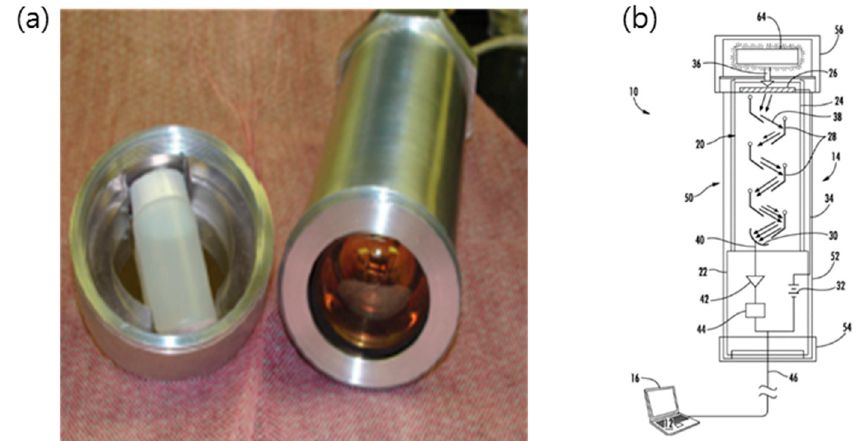
Figure 6. Portable rapid tritium analysis system (PoRTAS) detector: ( a ) PoRTAS detector and cap and ( b ) PoRTAS system plane [69].